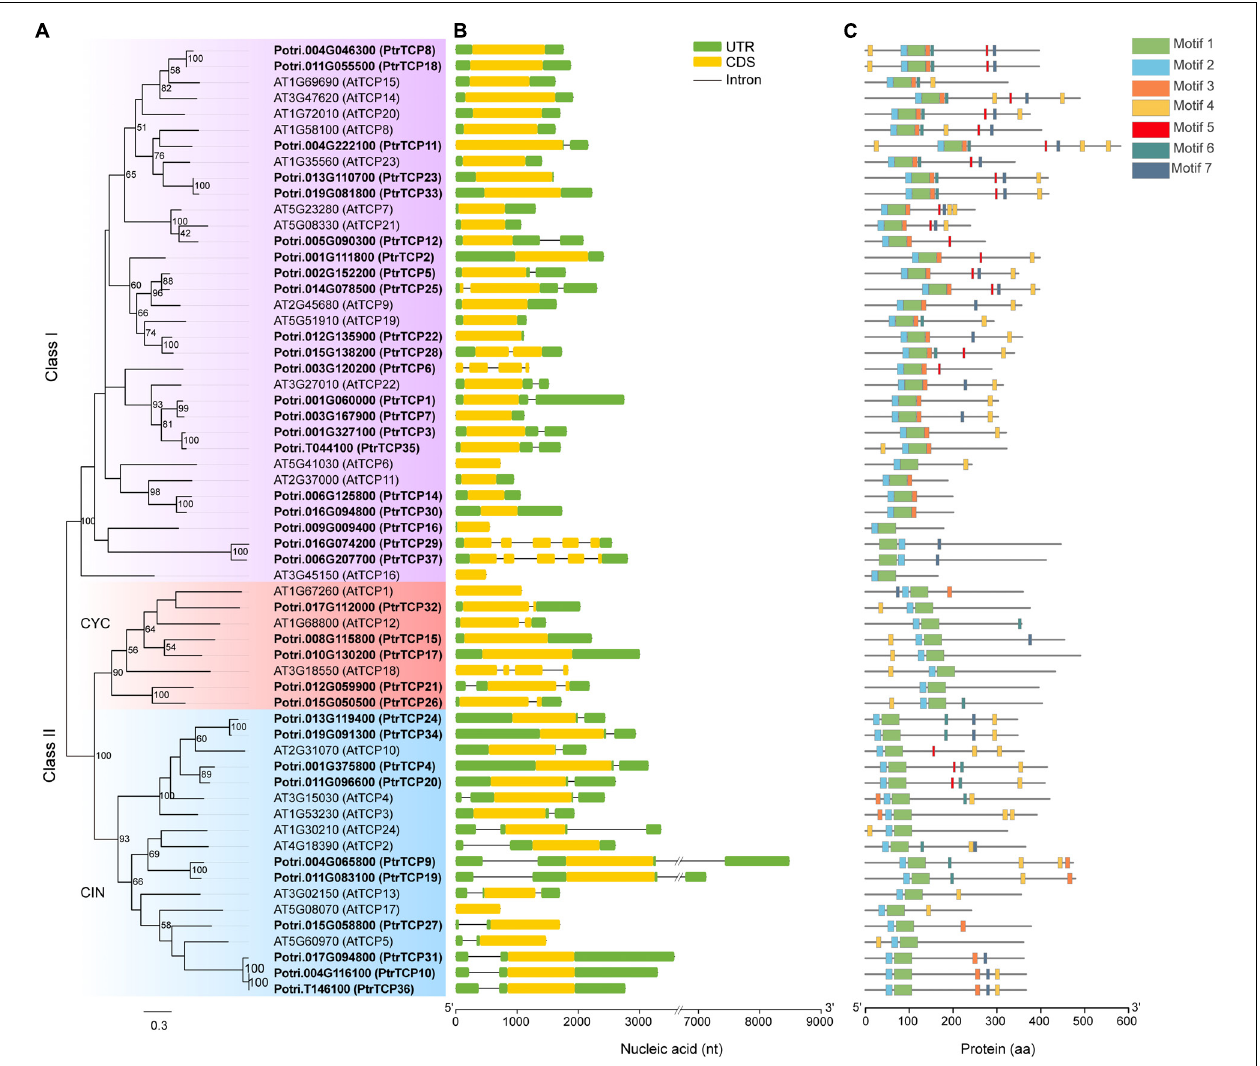
FIGURE 1 | Phylogenetic analysis and architecture of TEOSINTE BRANCHED1/CYCLOIDEA/PROLIFERATING CELL FACTOR ( TCP ) family genes in Populus trichocarpa and Arabidopsis . (A) Phylogenetic analysis of TCP family genes. The amino acid sequences of P. trichocarpa (in bold) and Arabidopsis TCP proteins were aligned to construct the phylogenetic tree using maximum-likelihood (ML) method with 1,000 bootstrap replicates. Genes clustered in the same subfamily are marked by the same color. (B) Exon/intron structures of TCP family genes. Exon and intron are represented by a colored rectangle and black line, respectively. Of the exon, the yellow rectangle represents coding sequence (CDS) and the green rectangle represents 5 (cid:48) UTR or 3 (cid:48) UTR. (C) Distribution of the conserved domains or motifs in TCP proteins. Different kinds of conserved motifs are indicated by the rectangles with different colors.